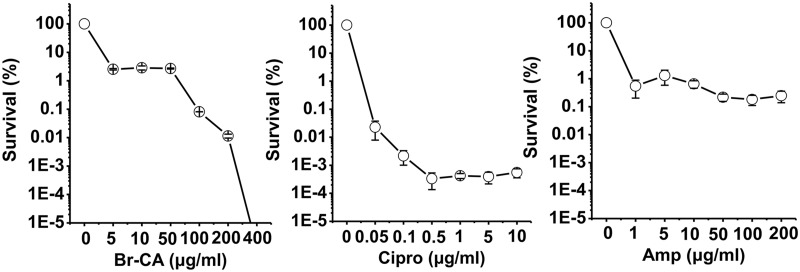
Killing curves of MG1655 cells in the stationary phase by Br-CA, Cipro and Amp.Cell survival percentage after treatment was calculated based on the colony counts on the LB agar plates. Each data point or bar was indicated as the means of three replicates ± standard deviation.